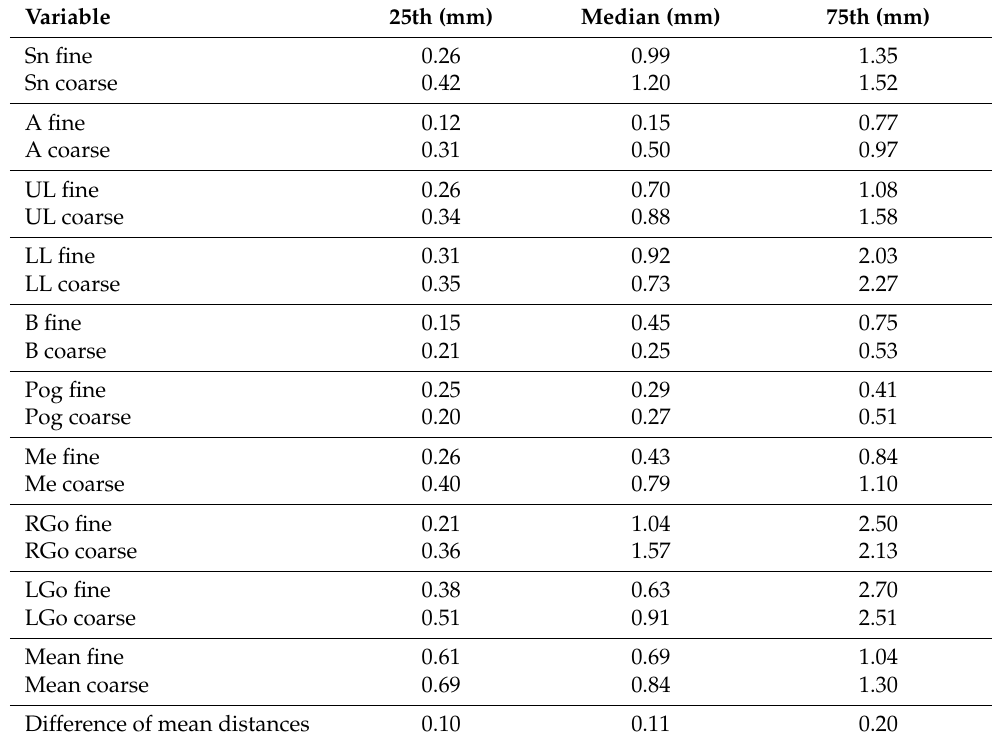
Table 2. First quartile, median and third quartile of distances for each anatomical landmark and type of mesh, for the mean distance per each type of mesh and for the difference of the mean distances.